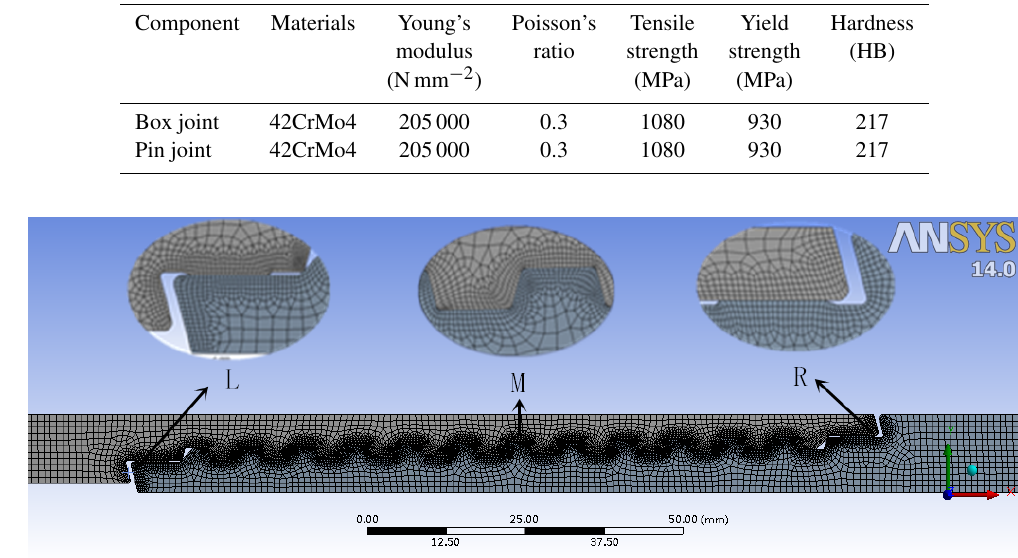
Figure 5. Finite-element model (L – left shoulder; M – middle screw; R – right shoulder).